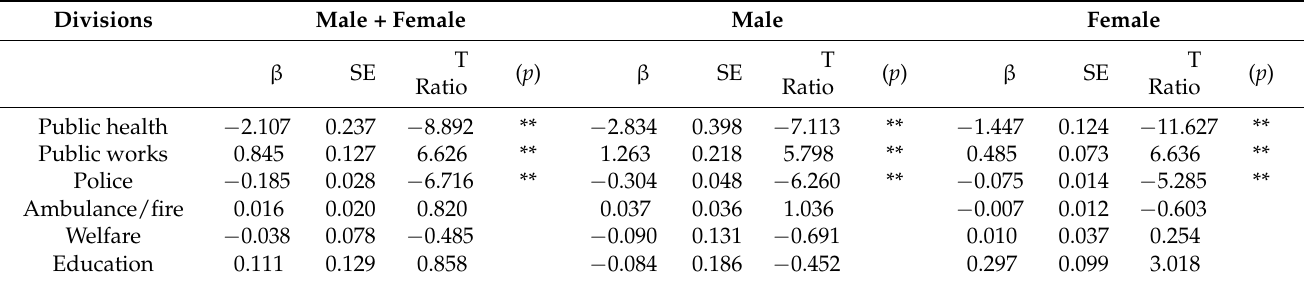
Table 1. Effects of financial expenditure ratio of six divisions of prefectures and municipalities on suicide mortality.